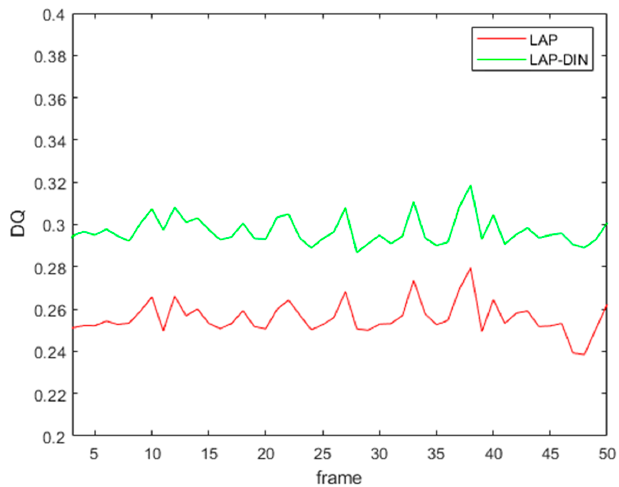
Figure 6. Video fusion performance of proposed local energy HF detail fusion (green) compared to conventional frame-by-frame select-max fusion (red) measured using objective fusion performance metric DQ .